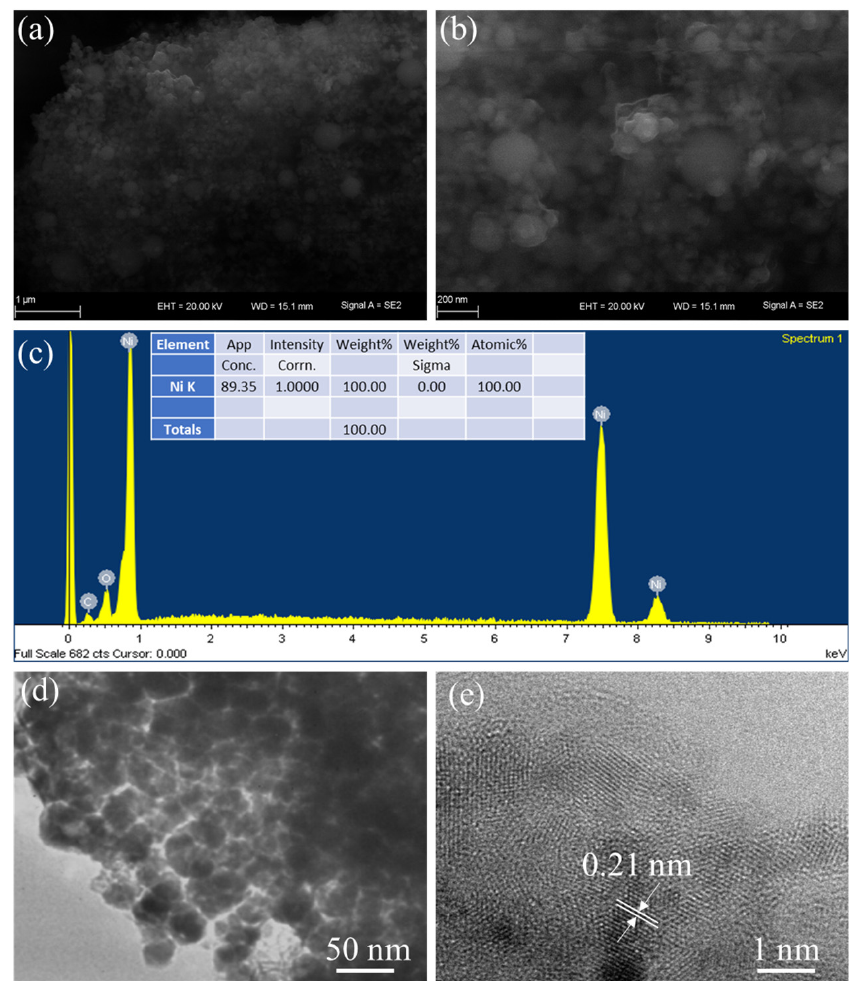
Figure 3. ( a , b ) Low- and high-resolution SEM images of Ni-NPs; ( c ) EDX elemental mapping; ( d , e ) low- and high-resolution TEM images of Ni-NPs.